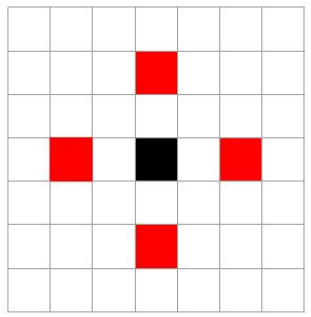
Figure 15. Map of views studied to evaluate the ray-difference features as described in